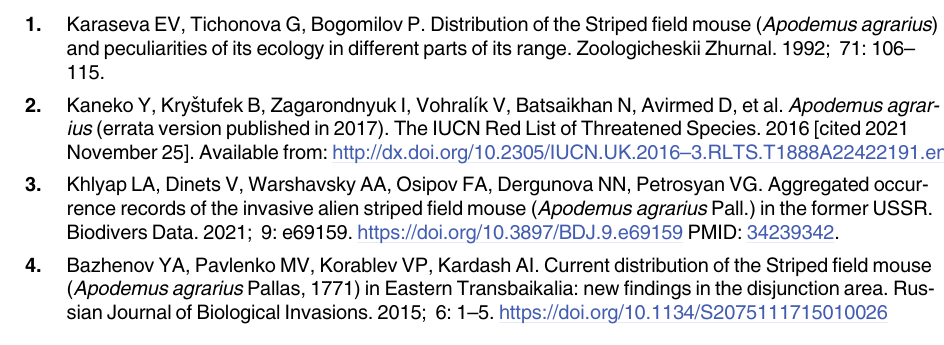
S2 Table. List of cyt b haplotypes, which together with haplotypes listed in S1 Table, used in variable sites distribution analysis. S3 Table. The number (N) and percentage (%) of polymorphic sites of each fragment length 50 bp of A . agrarius cyt b . Analysis was carried out using 593 complete and partial sequences, including both original and GenBank data (S1 and S2